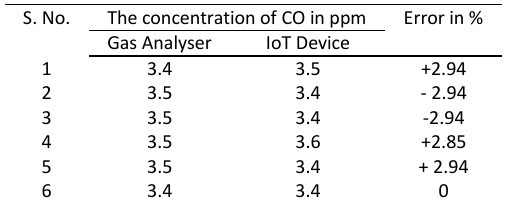
Table 3: Comparison of CO concentrations observed from Optima Table 3 Comparison of CO concentrations observed from Optima Gas Analyser and IoT Device Gas Analyser and IoT Device S. No.